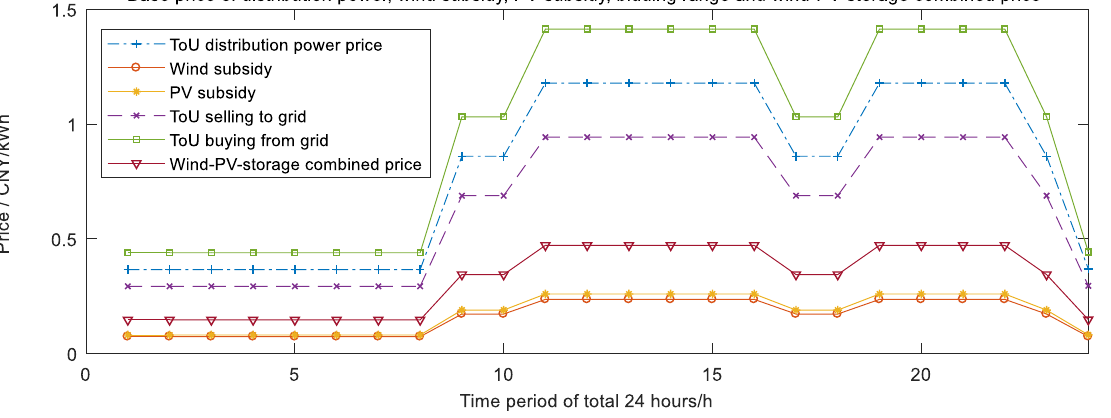
Figure 14. The base reference price of distribution power from superior power grid, the wind subsidy, PV subsidy, base minimum and maximum price of bidding range, and wind-PV-storage combined price.